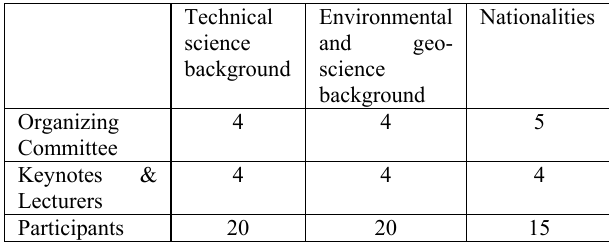
Table 1. Composition of organizing committee, keynote speakers, lecturers, and participants